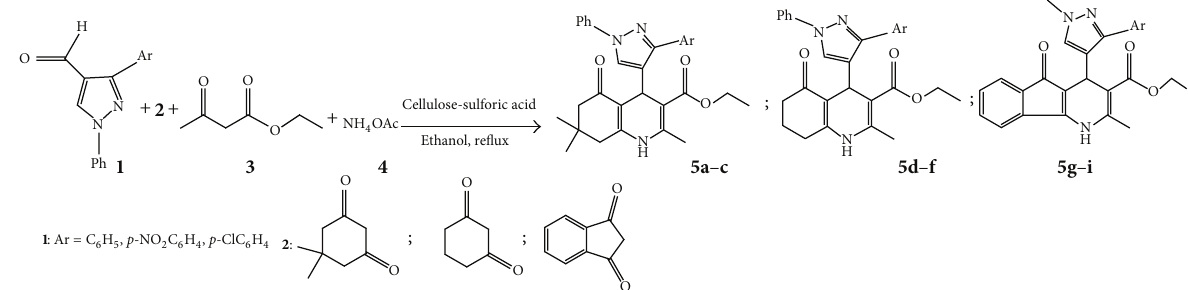
Scheme 1: Efficient synthesis of fused